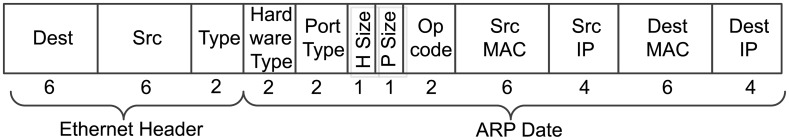
Packet format of ARP.